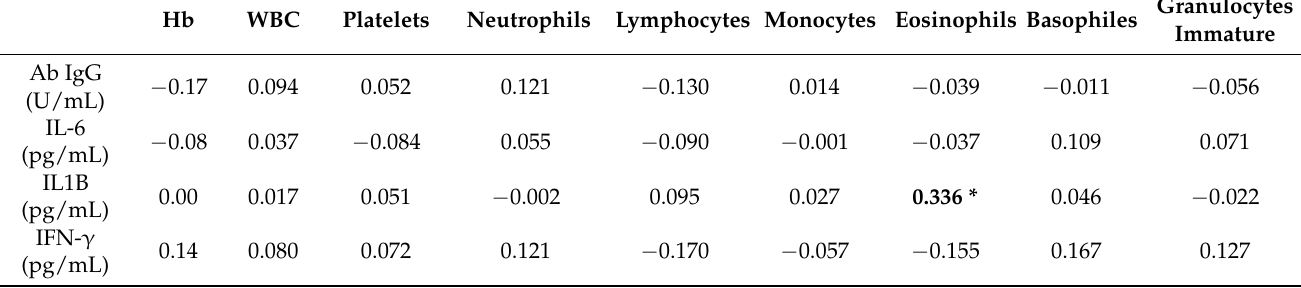
Table 6. Correlations between cytokines concentrations and maternal blood cells count. Pearson’s significant correlation coefficients have been